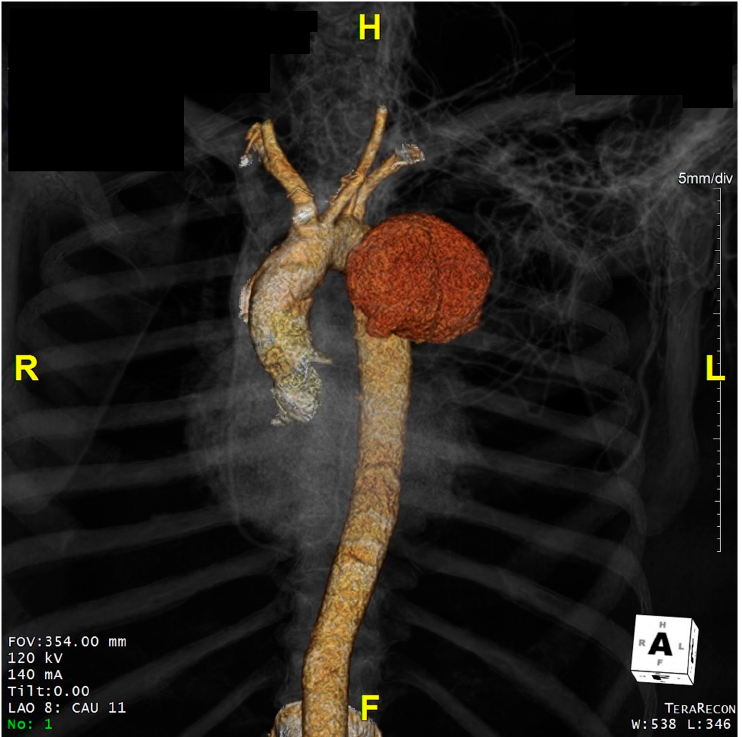
Figure 3. Patient 7. Severe aneurysmatic dilatation of the distal aortic arch and proximal descend- ing thoracic aorta with compression of the left branch of the pulmonary artery.